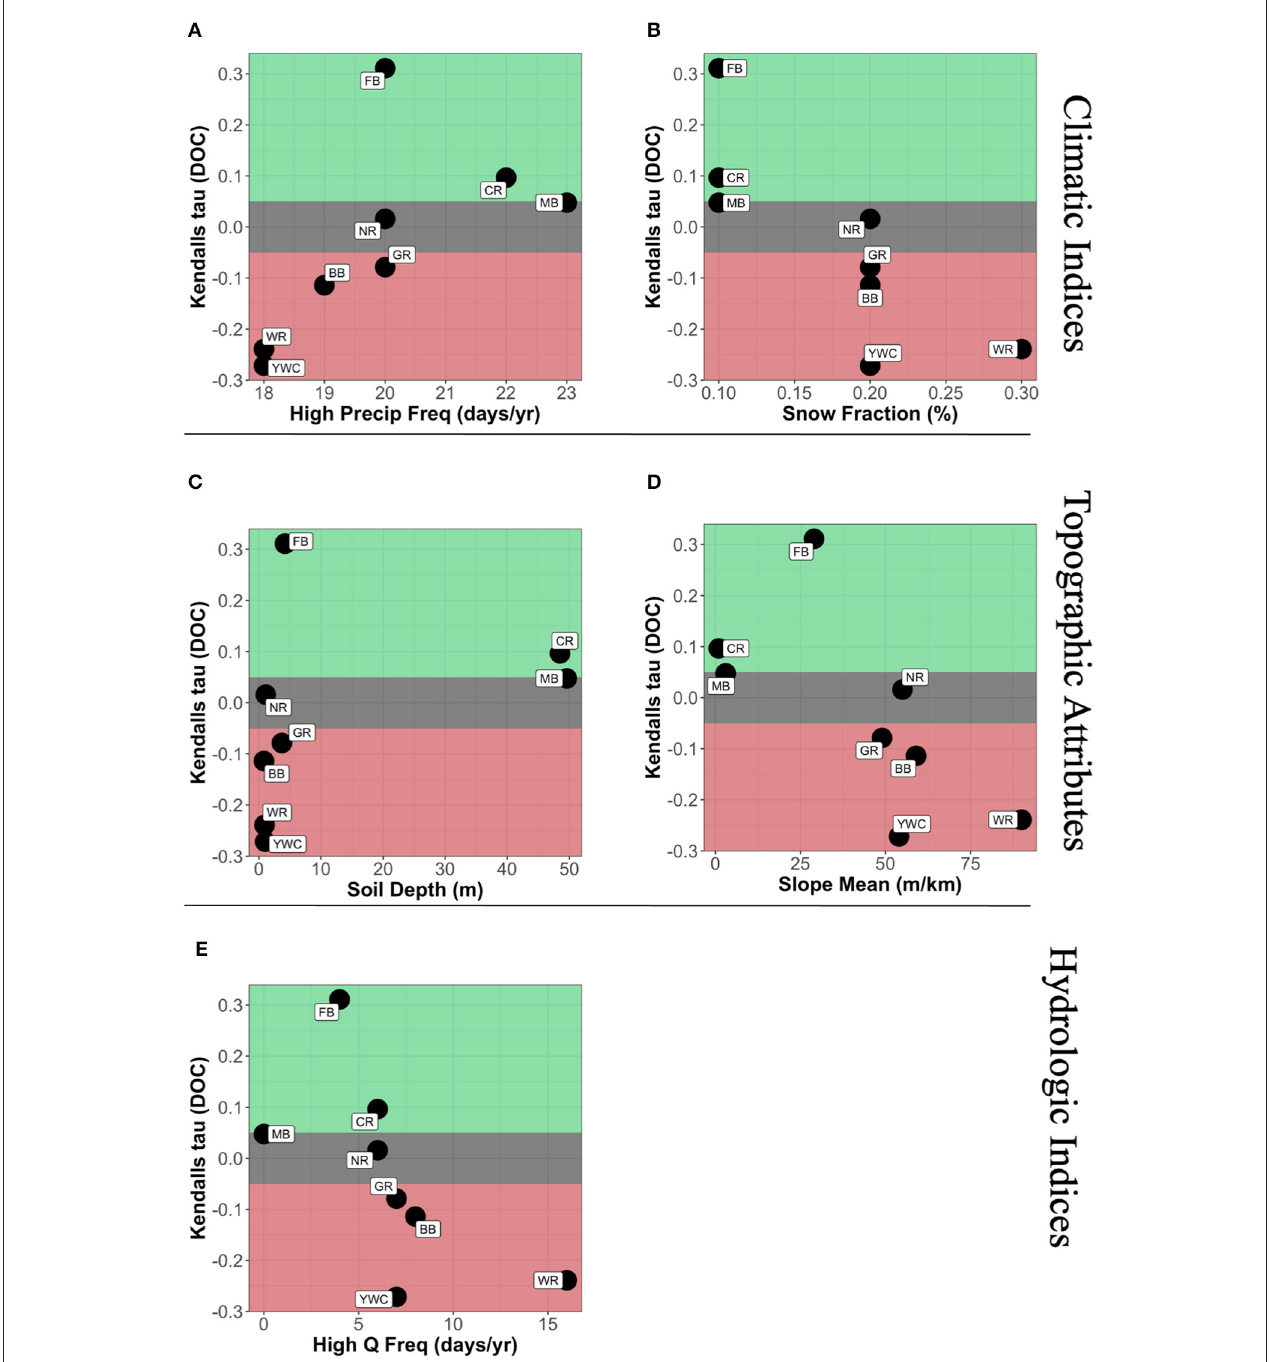
FIGURE 7 | Relationship between trends in flow-adjusted dissolved organic carbon concentration (DOC FA ) (2004–2018) and select catchment attributes grouped as climatic indices (A,B) , topographic indices (C,D) , and hydrologic indices (E) . Shading highlights those regions of the plot where DOC FA exhibits statistically-significant positive trends (tau > 0.05; green), negative trends (tau < − 0.05; red), or no significant trend (0.05 > tau > − 0.05;